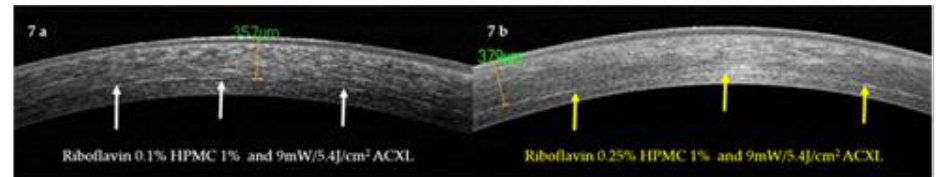
Figure 7. ( a ) Demarcation line depth (DLD) after 9 mW/5.4 J/cm 2 ACXL using 0.1% riboflavin and 1% HPMC (white arrows); ( b ) DLD after 9 mW/5.4 J/cm 2 ACXL using 0.25% riboflavin and 1% HPMC (yellow arrows).